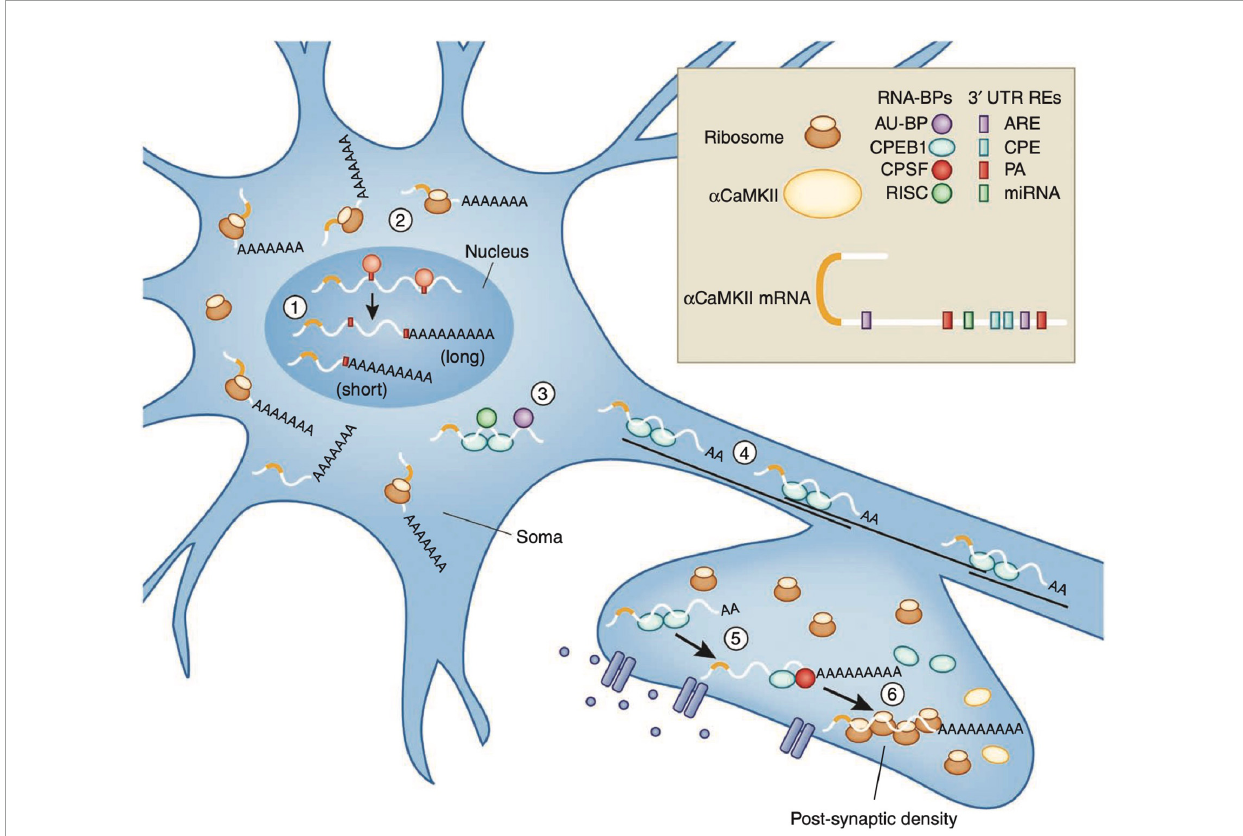
FIGURE6 Recycling of α CaMKII mRNA in neurons. Alternative polyadenylation (APA) of α CaMKII mRNA generates two transcripts with 3 (cid:48) UTRs of different lengths (1). Both transcripts are polyadenylated in the nucleus, but the composition of the cis- elements in their 3 (cid:48) UTR modifies their cytoplasmic fates. The short isoform is translated mainly in the soma (2), whereas miRNA binding sites, AU-rich elements (AREs) and cytoplasmic polyadenylation elements (CPEs) mediate deadenylation, repression (3) and transport (4) of the long transcript to dendrites. Upon neuronal stimulation in the post-synaptic densities (PSD), CPEB1 promotes α CaMKII mRNA polyadenylation (5), and α CAMKII local translation (6). Figure from Weill et al. (2012), obtained by Springer Nature under license No